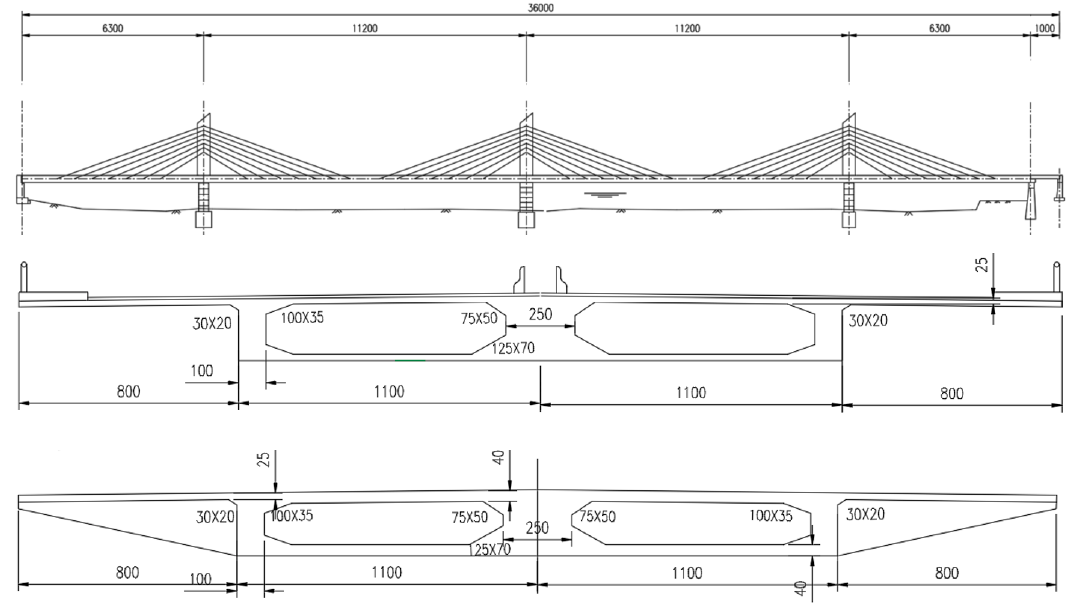
Figure 5. Three-tower cable-stayed bridge and the schematic diagram of the box girder structure.